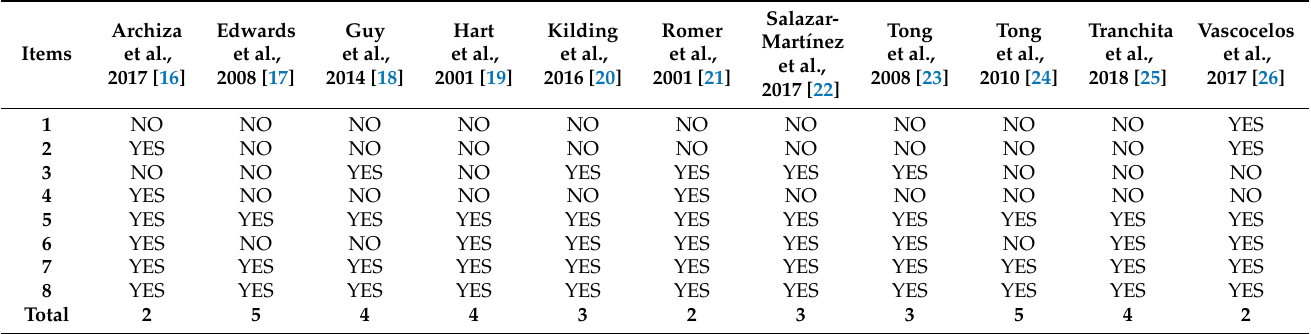
Table 3. Cochrane’s assessment of risk of bias